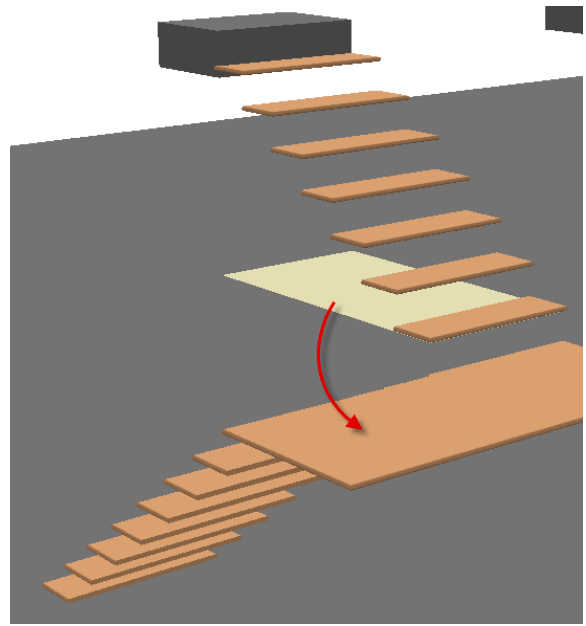
Figure 12. Illustration of the method for searching for the connecting slab or stair landing of a stair flight.